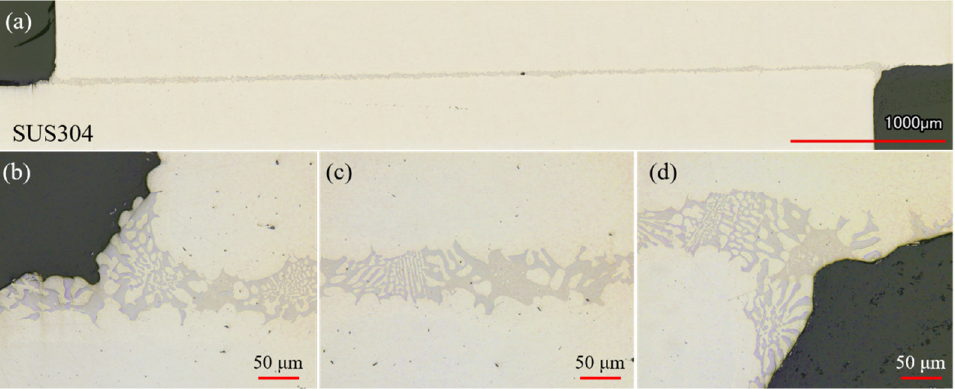
Figure 5. OM images of cross section of joint brazed with electrodeposited Ni-13.4Cr-11.6P alloy coating. ( a ) is overall view of brazed joint, ( b – d ) are partically magnified images of ( a ).